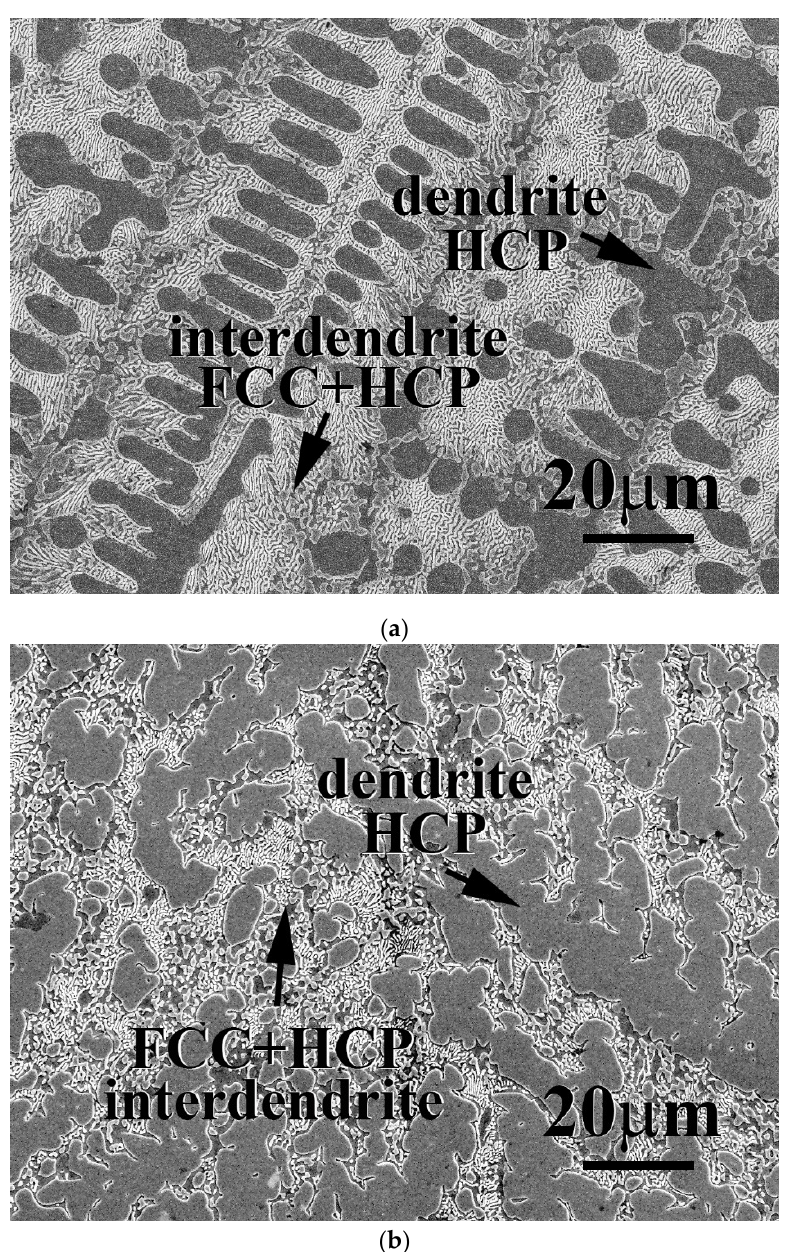
Figure 6. SEM micrographs of as-cast CrFeCoNiNb x Mo 1 − x alloys: ( a ) CrFeCoNiNb 0.25 Mo 0.75 alloy and ( b ) CrFeCoNiNb 0.75 Mo 0.25 alloy. Table 6. The chemical compositions of the as-cast CrFeCoNiNb x Mo 1 − x alloys and the phases in each alloy analyzed by SEM/EDS.